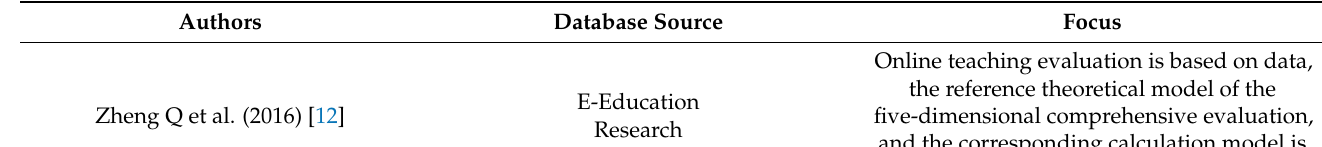
Table 1. Summary of the network evaluation system